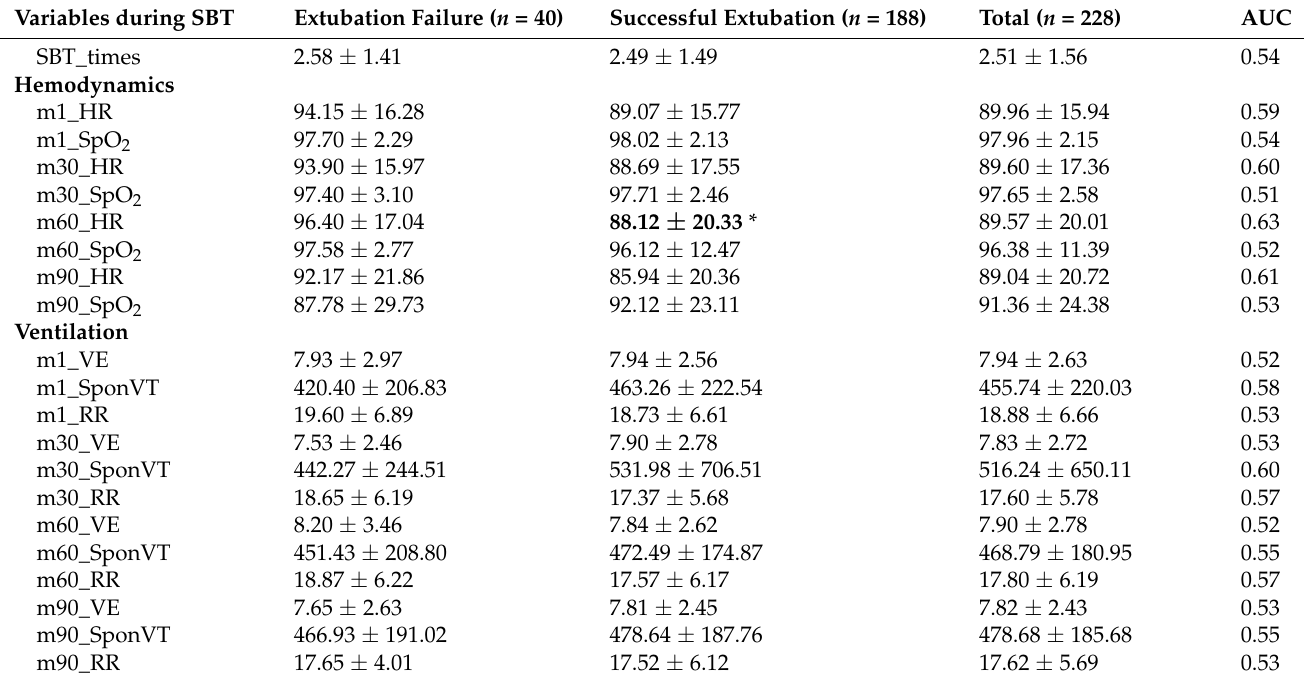
Table 5 lists the variables measured during the SBTs of the 228 patients. A significant between-group difference was only observed for the heart rate (HR) in the 60th minute. The AUC of this variable was 0.63. Table 5. SBT variables of the 228